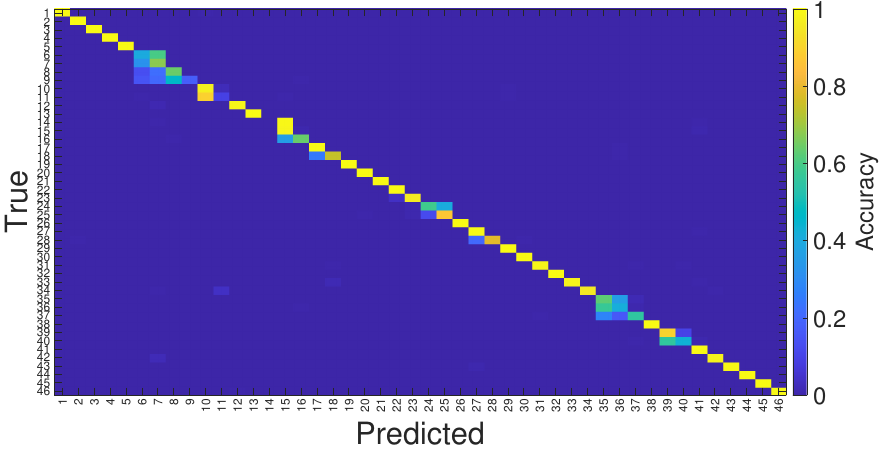
Figure 11. Confusion matrix with WHT and Opt seg = 64 at SNR = 30 dB.